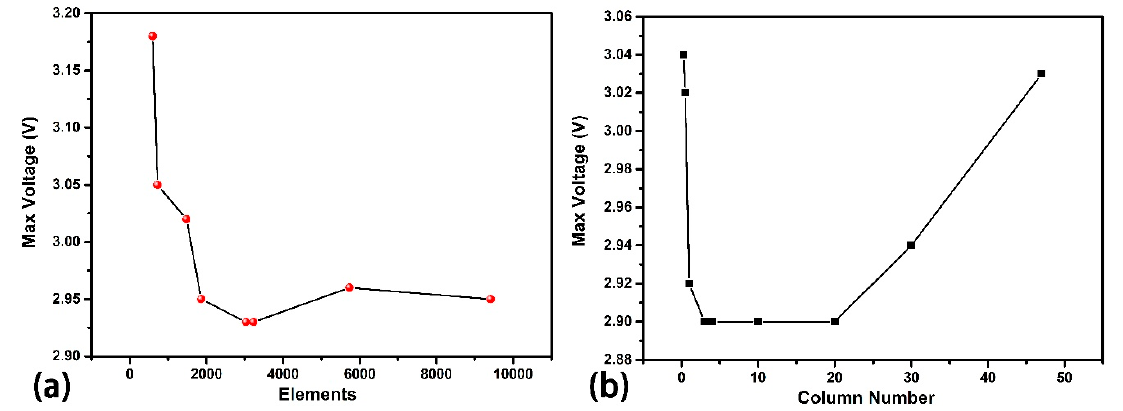
Figure 2. ( a ) Mesh Converge Diagram of the cylinder modified structure, of which bottom shape is 200 µ m × 200 µ m and the cylinder diameter is 30 µ m and the height is 30 µ m. The x axis is the element number after meshing, and the y axis is the max voltage of each mesh type. ( b ) Column Number Independence test. The cylinder modified structure is tested under di ff erent column number. For example, column number 4 means 4 × 4 columns locate on corresponding support base. Column number 0.5 means a semi-cylinder locates on the support base using periodic